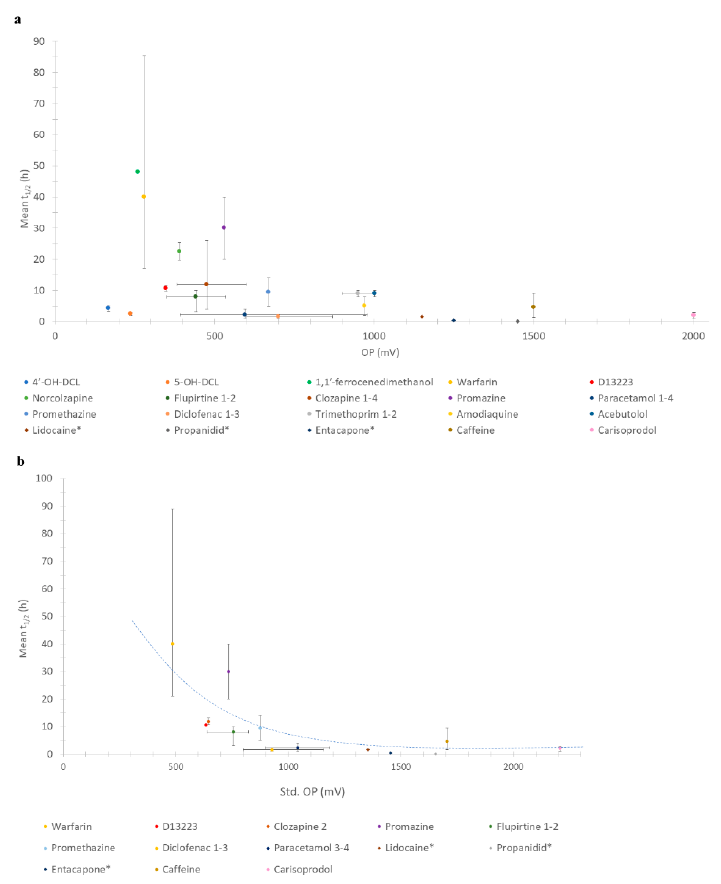
Figure 1. ( a ) Relationship between OP and half-life of all compounds; ( b ) Relationship between standardised OP (N.H.E.) and half-life. Key: * = additional drugs studied and number after the drug indicates which entries from Table 1 were standardized.